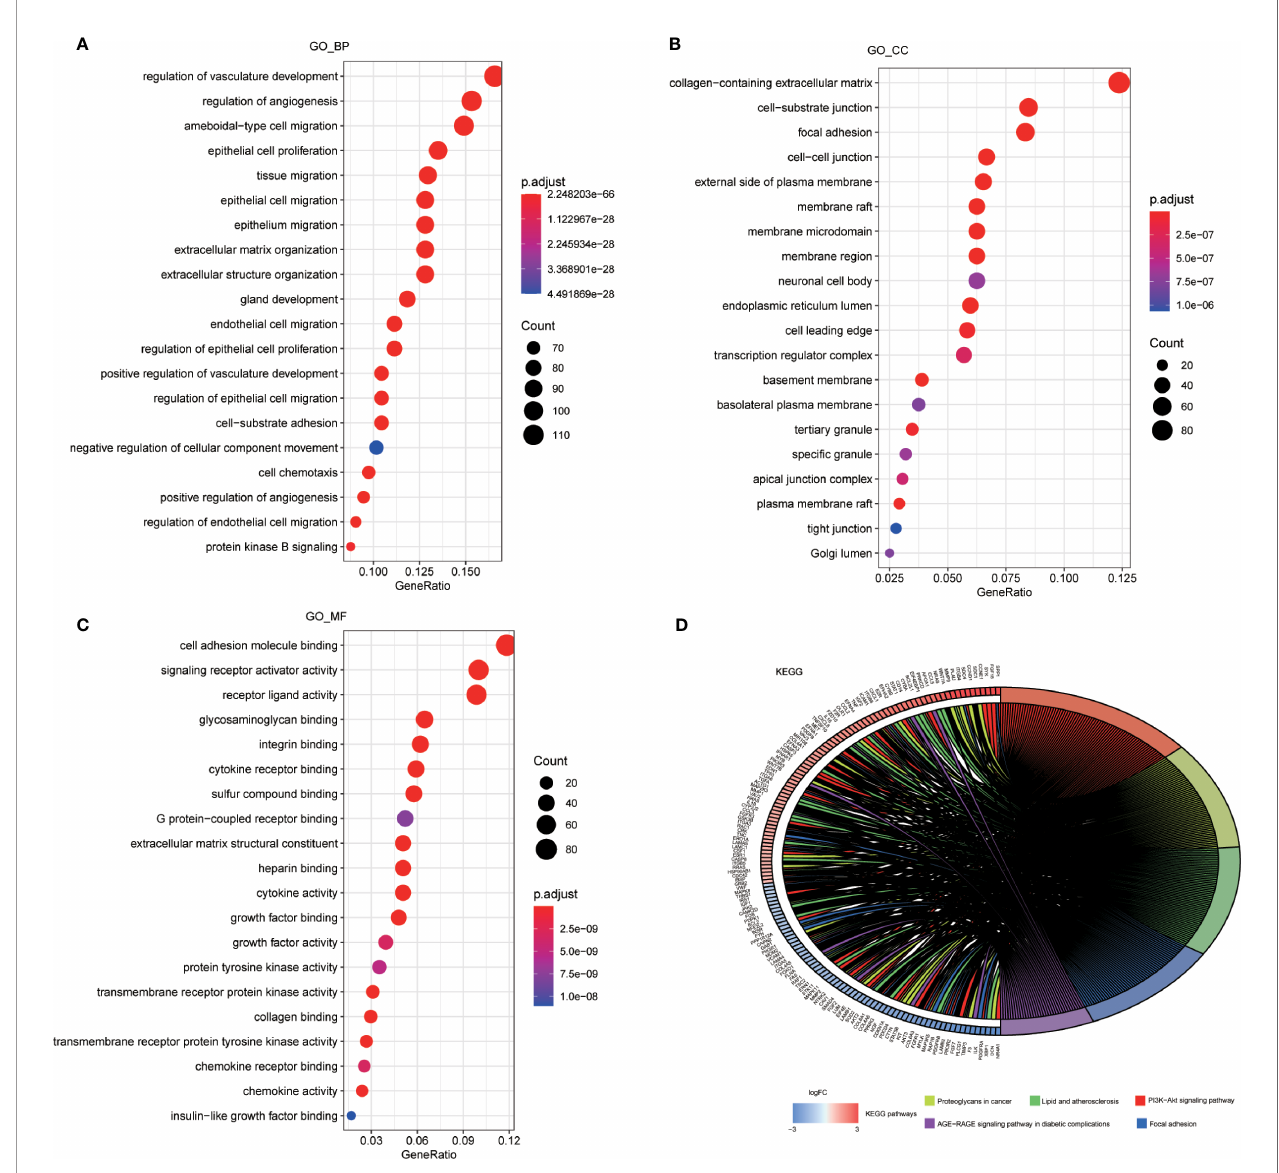
FIGURE 2 | Enrichment analysis of ARGs. (A) Top 20 most signi fi cant biological processes in GO analysis. (B) Top 20 most signi fi cant cellular components in GO analysis. (C) Top 20 most signi fi cant molecular function in GO analysis. (D) Top 20 most signi fi cant KEGG